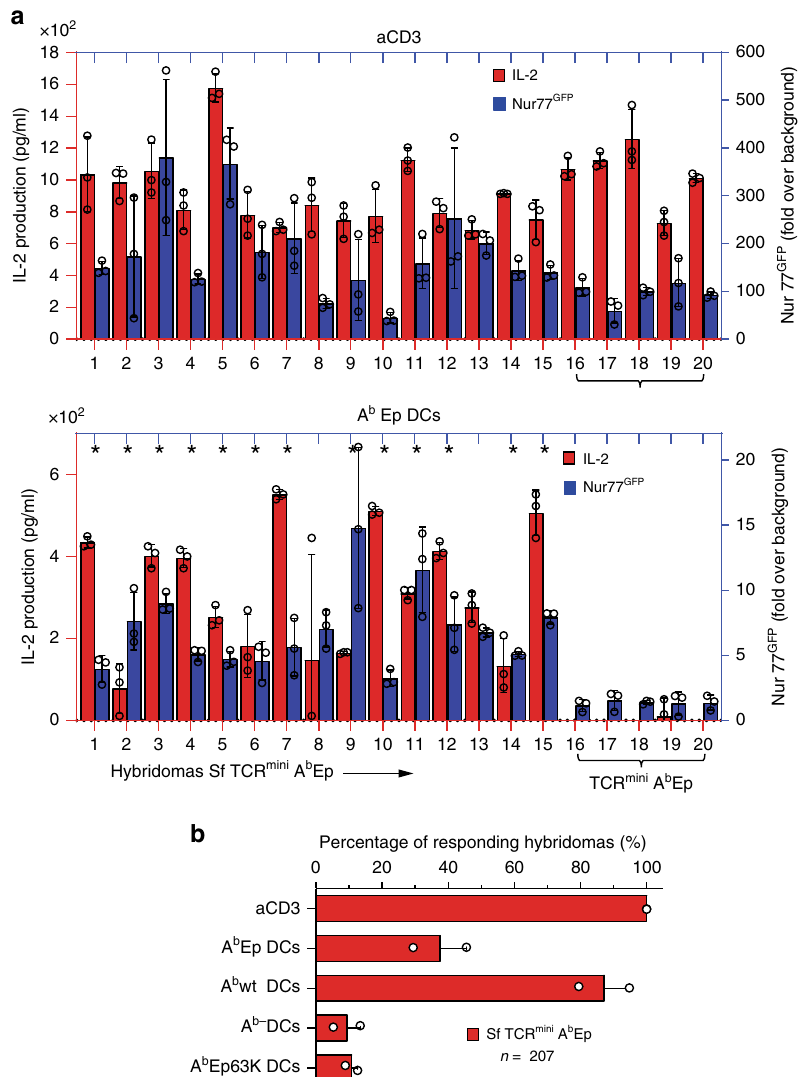
Fig. 5 Positively selecting self-peptide activates SfCD4 + hybridomas. a IL-2 production (red bars) and Nur77 GFP reporter expression (navy bars) by representative hybridomas from SfTCR mini A b Ep (#1-15) or control TCR mini A b Ep (#16-20) mice stimulated by aCD3 MoAb (upper panel) or autologous DCs expressing only A b Ep complexes (lower panel). For TCR α CDR3 sequences see Supplementary Data 9. Stars mark hybridomas whose TCRs are also expressed by naive CD4 + Foxp3 GFP − cells in healthy TCR mini A b Ep mice. b Percentage of hybridomas from SfTCR mini A b Ep mice that responded to DCs expressing endogenous self-peptides (A b wt), covalently linked autologous (A b Ep) or non-autologous (A b Ep63K) self-peptide, or lacking A b expression (A b − ). Source data are provided in a Source Data fi le. Error bars show